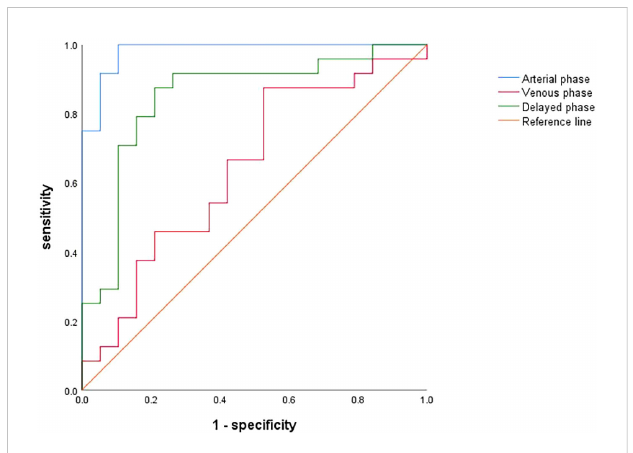
FIGURE 8 ROC curves for assessing the diagnostic performance of regression equations constructed based on optimal texture features from the arterial (blue), venous (red) and delayed (green)